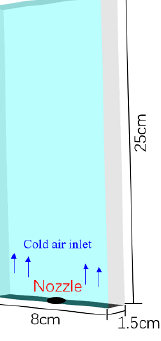
Figure 4. Structure diagram of pneumatic fluidized bed.